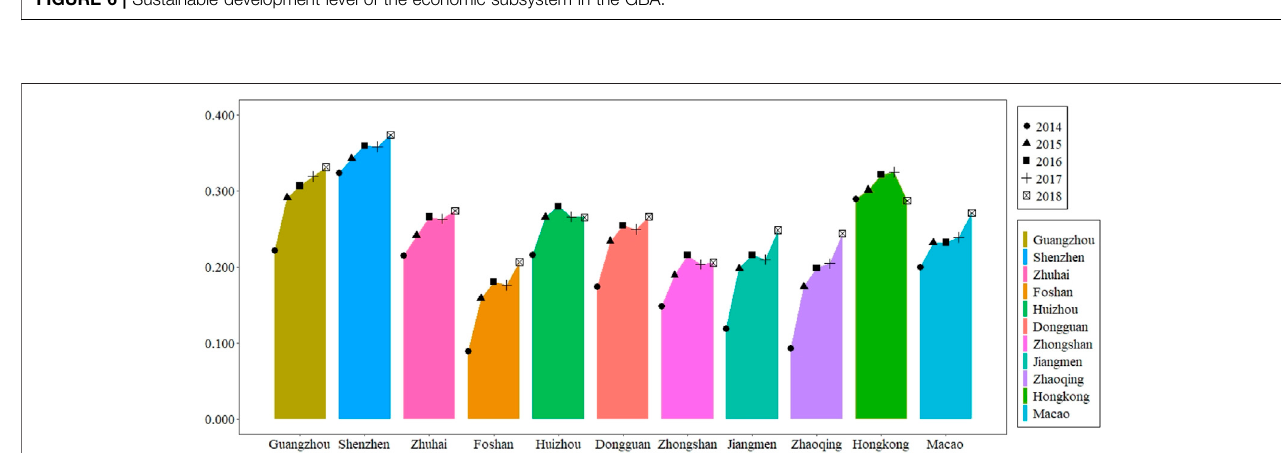
FIGURE 6 | Sustainable development level of the economic subsystem in the GBA.